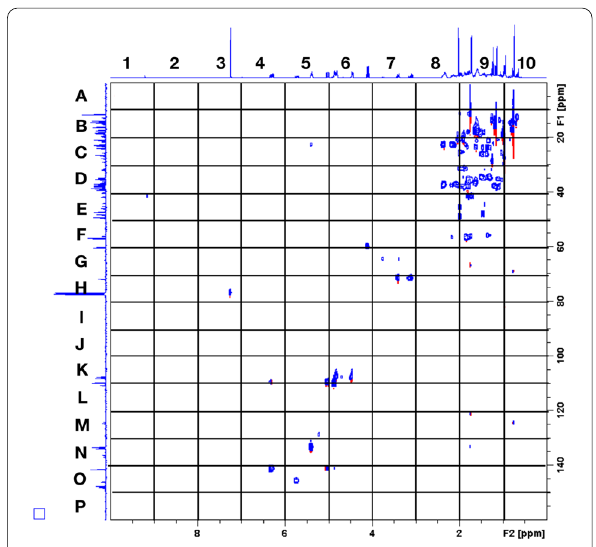
Fig. 1 HSQC NMR spectrum of the Cunninghamia konishii